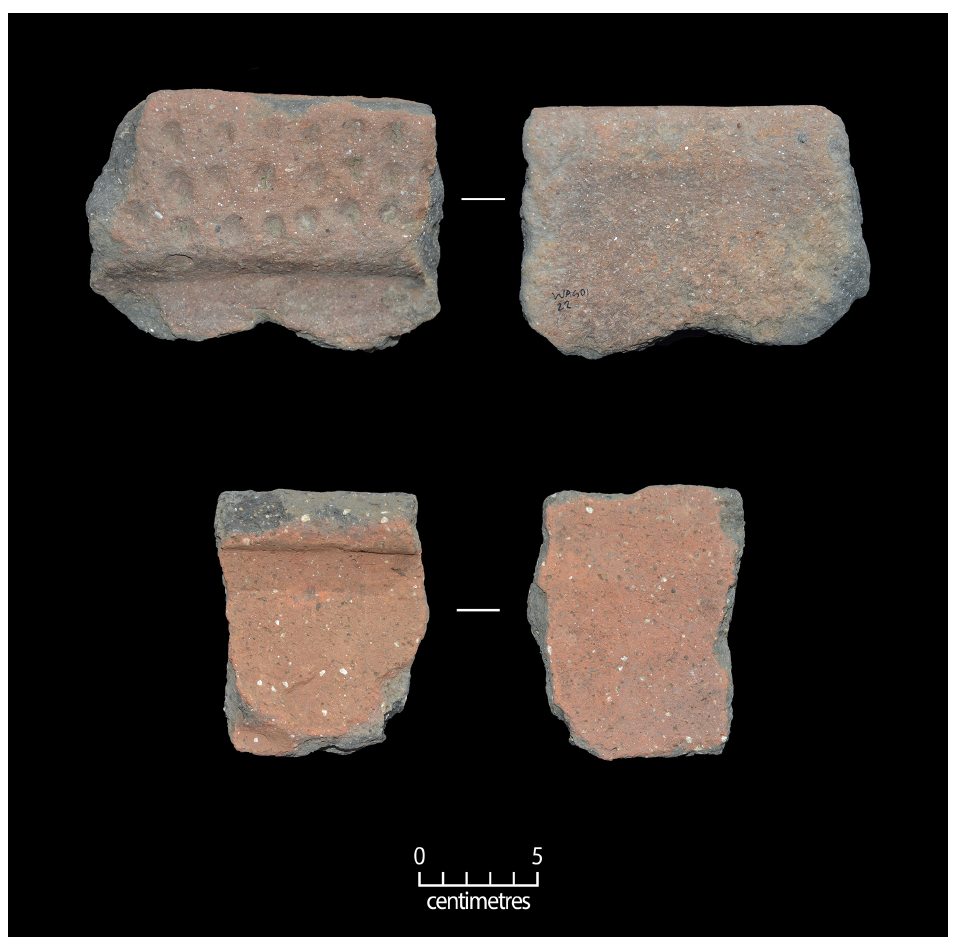
Figure 13: External and internal surfaces of two Class 4 variant 12 potsherds, including one decorated